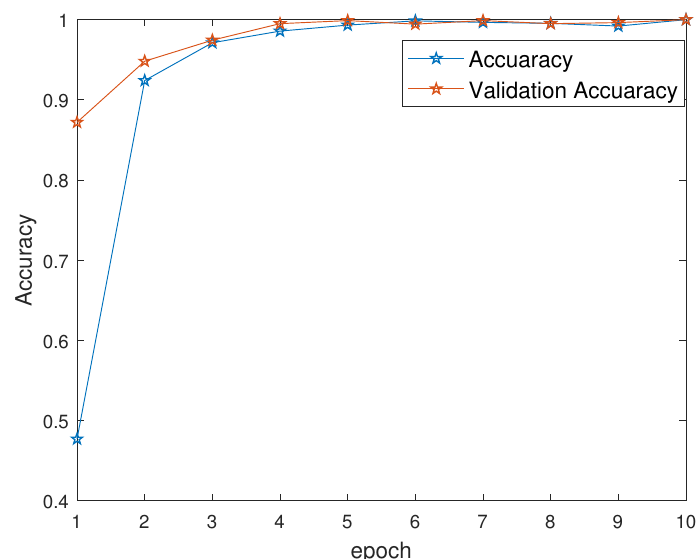
Figure 6. Model accuracy during the training of the